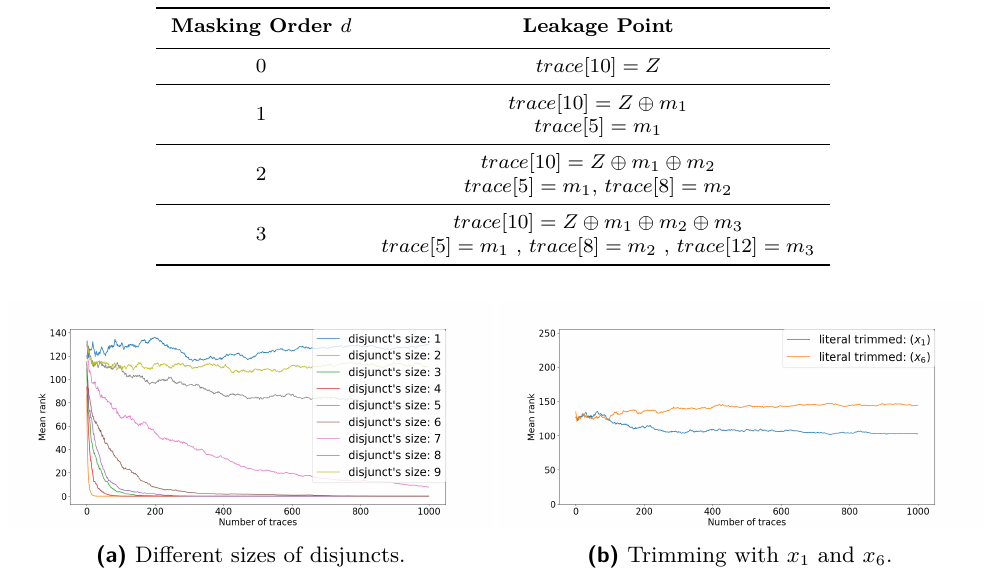
Table 2: Leakage points of the traces generated in simulated data based on the masking order.